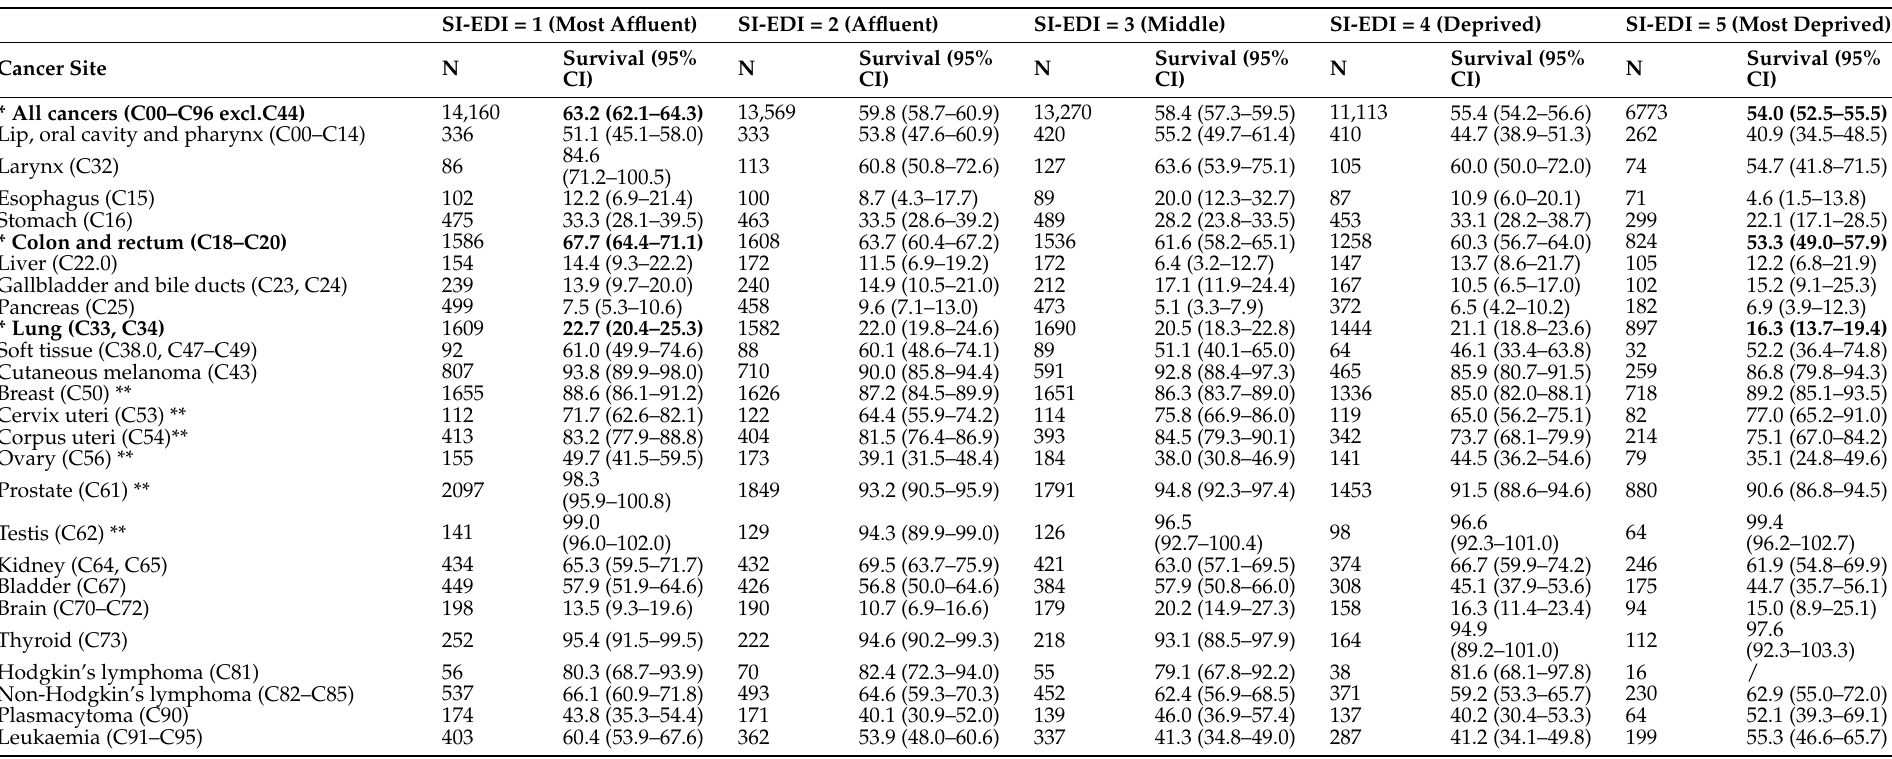
Table 1. Number of analyzed cancer cases (N) and five-year net survival with 95% confidence interval (CI) by cancer site according to ICD-10 classification and by Slovenian deprivation index (SI-EDI), both genders combined, Slovenia 2014 −